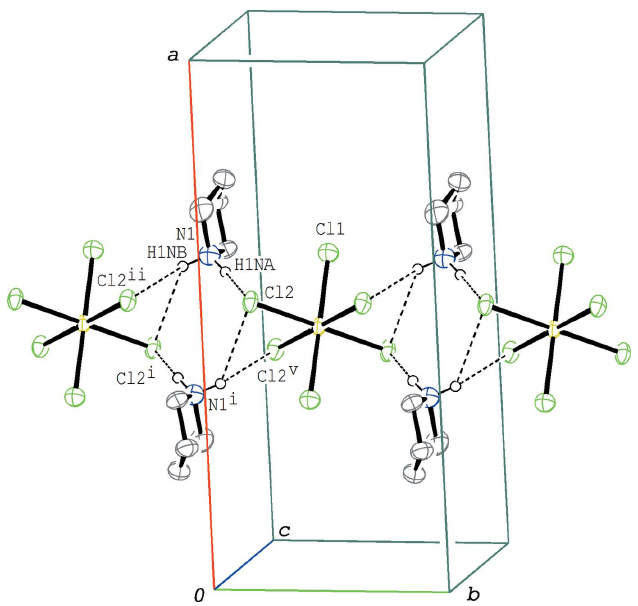
Figure 2 A partial packing diagram of the title compound, showing the tape-like structure formed by N—H (cid:2)(cid:2)(cid:2) Cl hydrogen bonds (dashed lines; see Table 1). Only one component is shown for the disordered cation. Displacement ellipsoids are drawn at the 50% probability level and H atoms, except those of the NH 2 group, have been omitted. [Symmetry codes: (i) (cid:3) x + 1, (cid:3) y , (cid:3) z ; (ii) x , (cid:3) y , z ; (v) (cid:3) x + 1, y , (cid:3) z .]